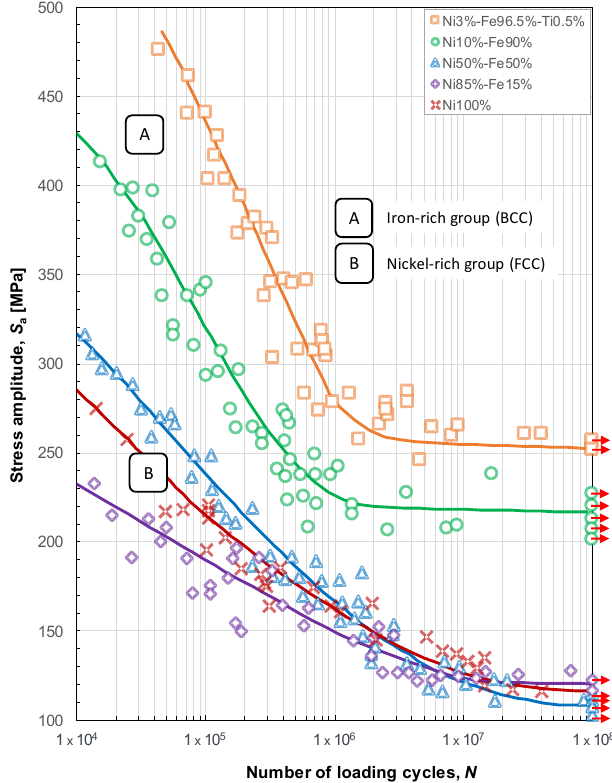
Figure 1. Comparison of fatigue life curves of iron-rich, which are of the body-centered cubic (BCC) type, with nickel-rich alloys, which are face-centered cubic (FCC). Fatigue life curves illustrate the existence of definite fatigue limits in BCC materials, reproduced from [2,5], with permission from Taylor & Francis, 1964.